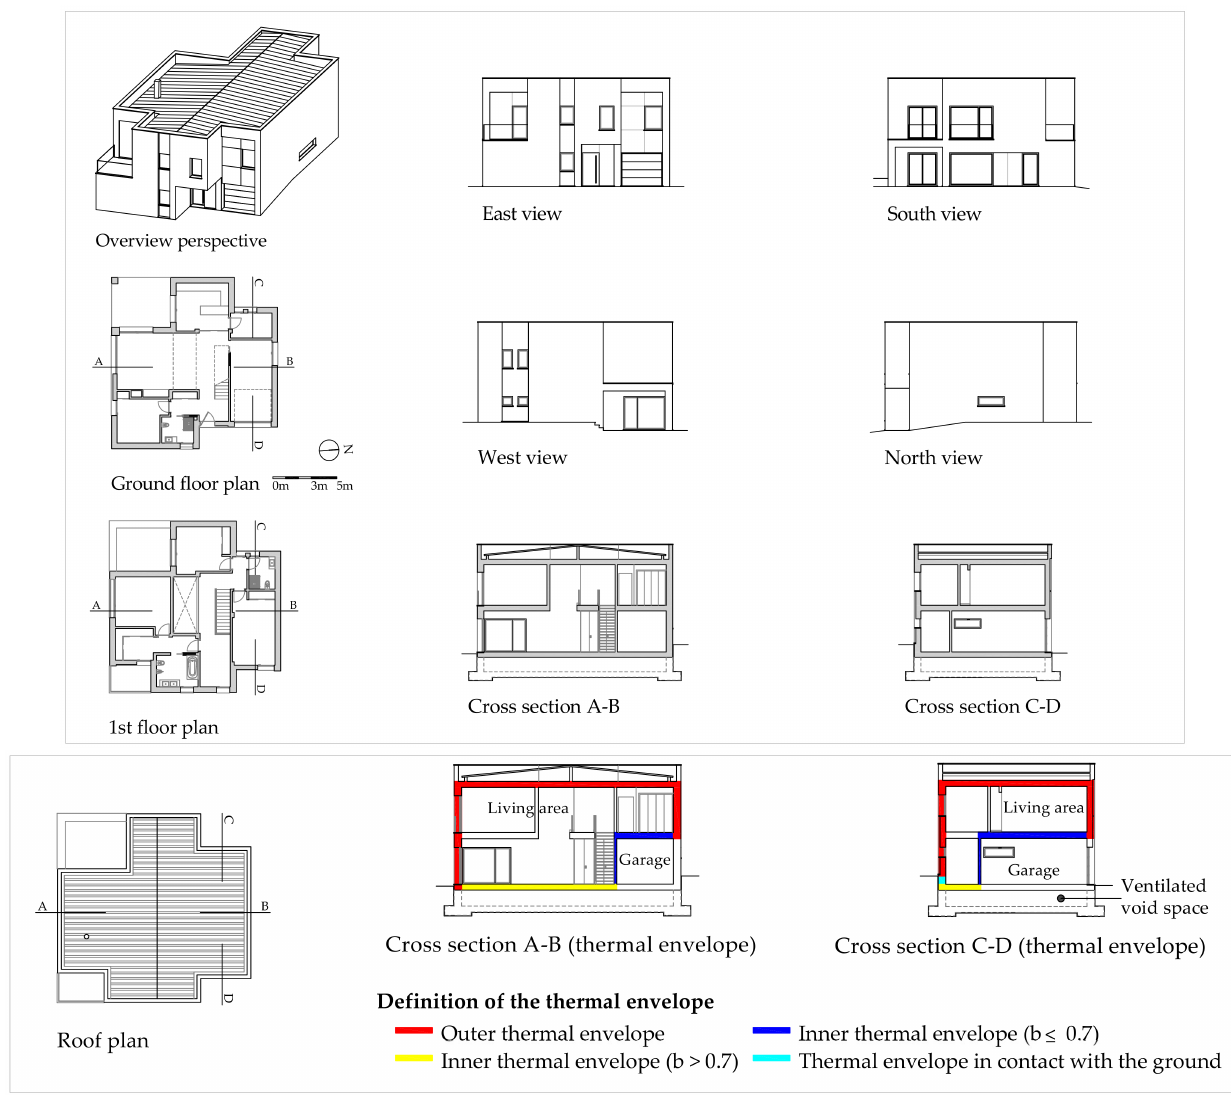
Figure 7. Case Study